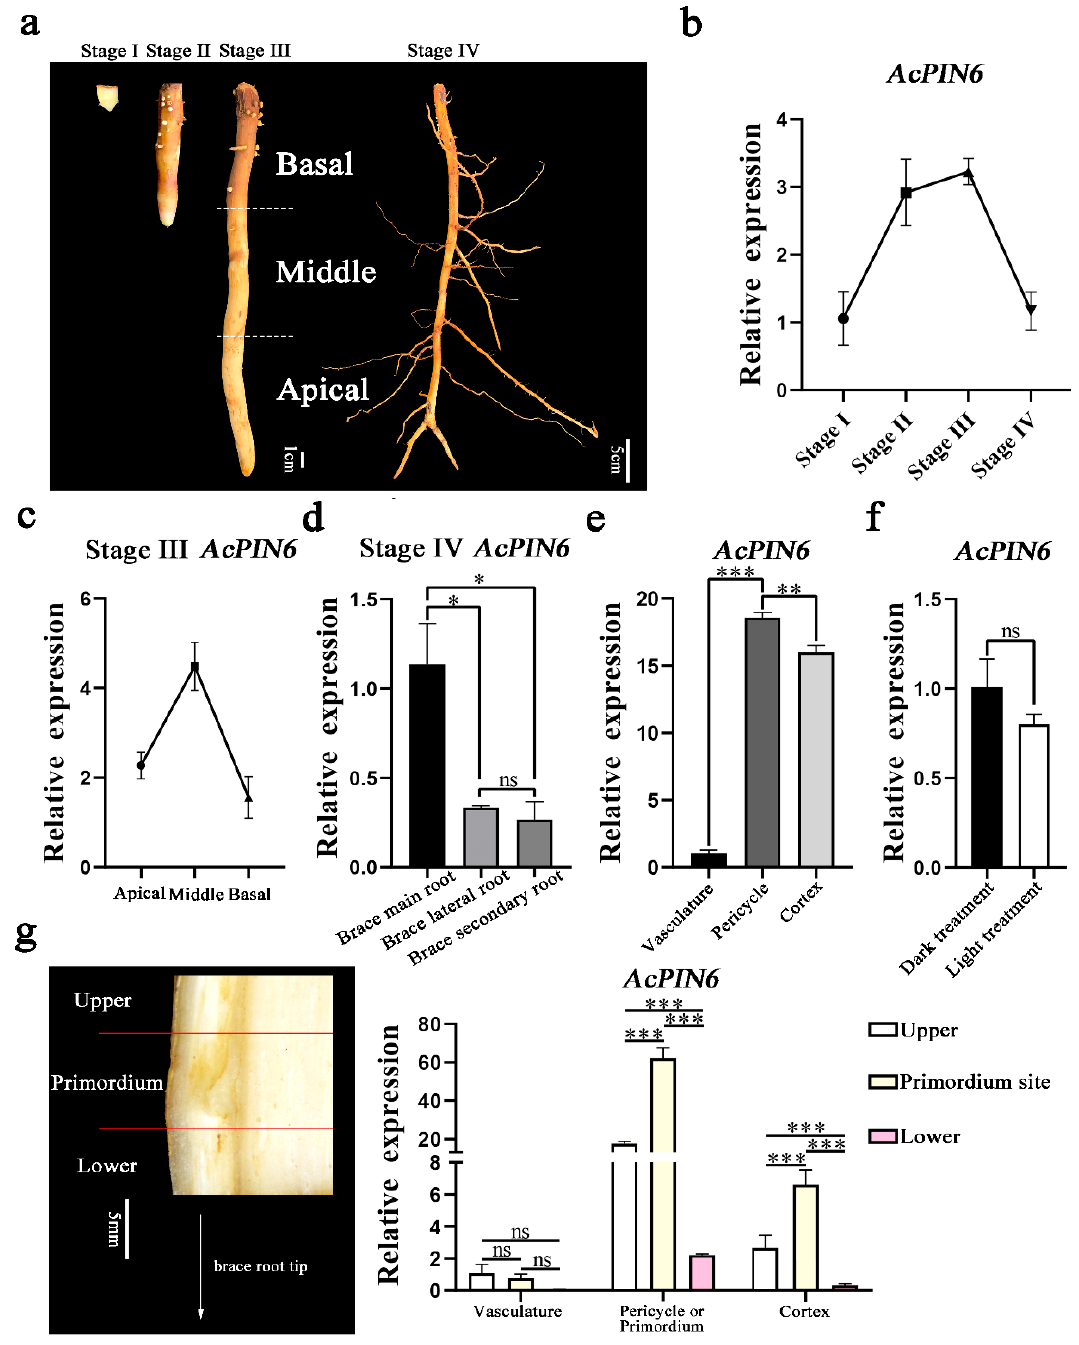
Figure 4. Expression analysis of AcPIN6 in different parts and growth stages of the A. catechu brace root. ( a ) Brace root successive growth stages; A: the apical part of the brace root, M: the middle part of the brace root, B: the basal part of the brace root. ( b ) qRT-PCR analysis of AcPIN6 during brace root growth. ( c ) qRT-PCR analysis of AcPIN6 in different parts of the brace roots during Stage III. ( d ) qRT-PCR analysis of AcPIN6 in the main brace root, brace lateral roots and brace secondary root during stage IV. ( e ) qRT-PCR analysis of AcPIN6 in vasculature, pericycle and cortex. ( f ) qRT-PCR analysis of AcPIN6 in brace roots pericycle under light and dark treatments. ( g ) Anatomical structure of the A. catechu brace root and qRT-PCR analysis of AcPIN6 in different tissues after lateral root primordia. Error bars represent means ± SE from three independent experiments (ns: p > 0.05; * p < 0.05; ** p < 0.01; *** p <